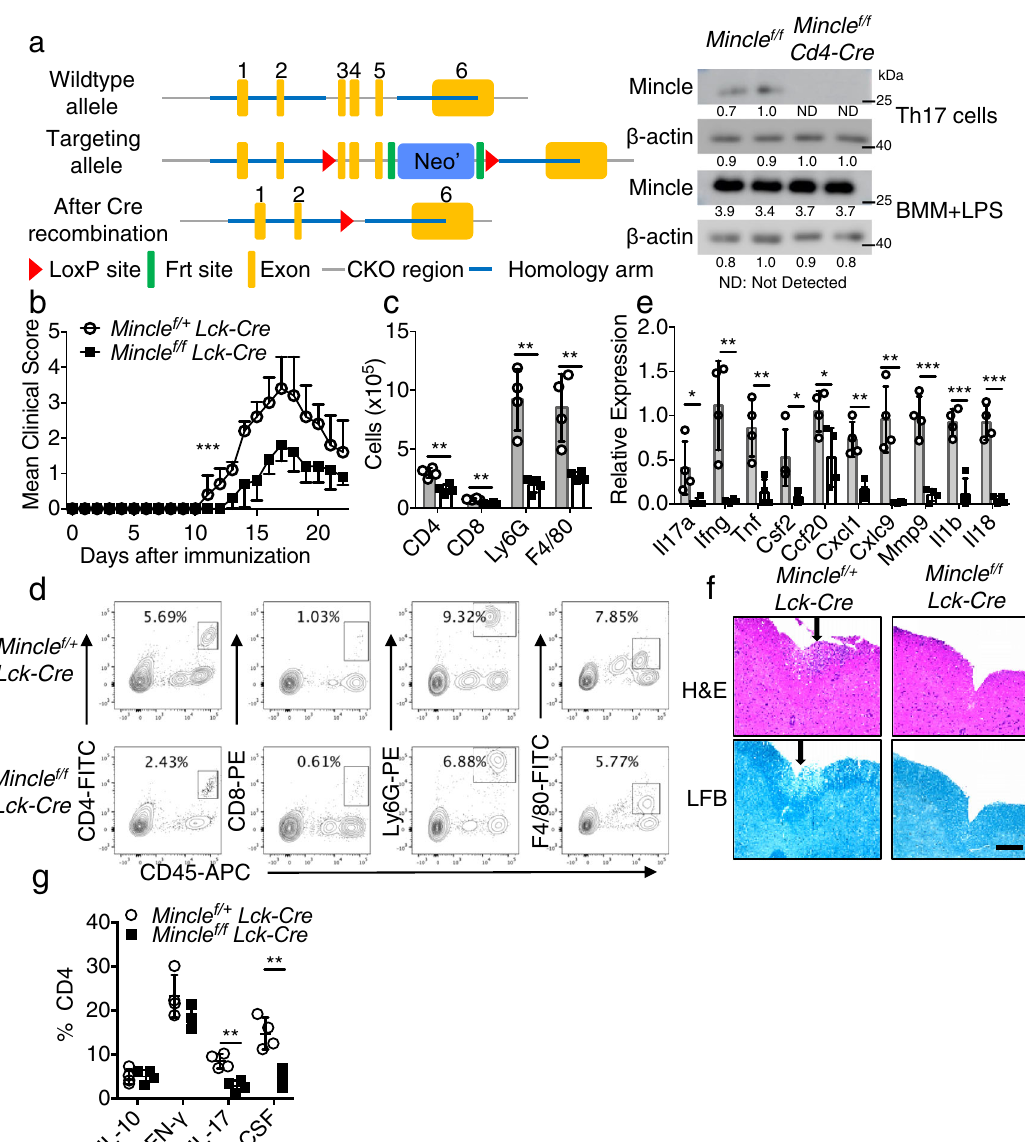
Fig. 2 T-cell-speci fi c Mincle deletion protects mice from EAE. a Targeting vector design for the generation of a mouse strain with fl anking Clec4e exon 3-5 by loxP sites and western analysis of Mincle protein expression in TH17 cells and bone marrow macrophages (1 μ g/ml LPS, 6 h) from Mincle f/ + Lck-Cre and Mincle f/f Lck-Cre mice, n = 2 for each genotype, density values measured using Image J for the representative blot shown, ND not detected. b Mean clinical score of EAE in Mincle f/ + Lck-Cre and Mincle f/f Lck-Cre mice ( n = 6 mice in each group) induced by active immunization with MOG 35-55 . c , d Absolute cell numbers ( c ) and gating strategy ( d ) of CNS-in fi ltrating cells were measured at the peak of disease by analyzing brain mononuclear in fi ltrating cells through fl ow cytometry with indicated antibodies, n = 4 biological replicates. e Real-time PCR analysis of relative mRNA expression of in fl ammatory genes in the spinal cord from Mincle f/ + Lck-Cre and Mincle f/f Lck-Cre mice at the peak of disease. Expression was normalized to β -actin mRNA, n = 4 biological replicates. f Hematoxylin and eosin (H&E) staining (upper panels) and Luxol fast blue staining (lower panels) of lumbar spinal cords from Mincle f/ + Lck-Cre and Mincle f/f Lck-Cre mice harvested at the peak of disease, Scale bars represent 100 μ m. Arrows in the upper panel indicate in fl ammatory cells in fi ltration, and arrows in the lower panel indicate demyelination area. Representative data are shown for n = 4. g Flow cytometry analysis of in fi ltrated cytokine-producing CD4 T cells in CNS at the peak of disease, n = 4 biological replicates. * P < 0.05, ** P < 0.01 (Two-sided student ’ s t test, c , e ). * P < 0.05 (Two-way ANOVA for b ). Data are represented as mean ± SD. Exact P values for asterisks (from left to right): b 0.0002 c 0.0032 0.0012 0.0017 0.0068 d 0.0446 0.0053 0.0062